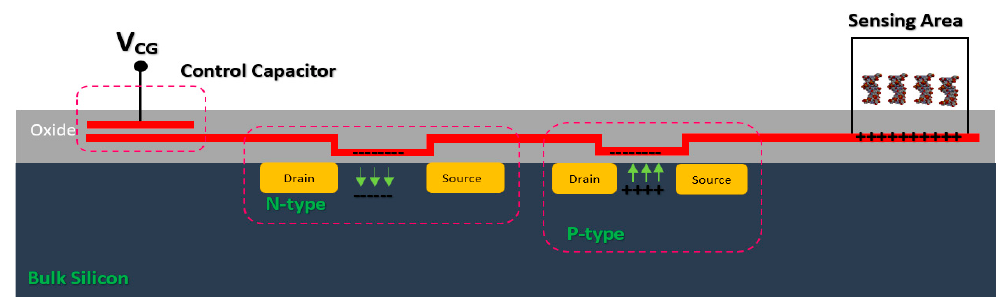
Figure 8. The floating gate structure and a real chip designed by Barbaro et al. for Label-free DNA analysis. This sensor contains 80 biosensors that are placed in 2 channels. Additionally, on this chip, a microfluidic system has been bonded which provides access to the sensing areas for test solutions and reagents.